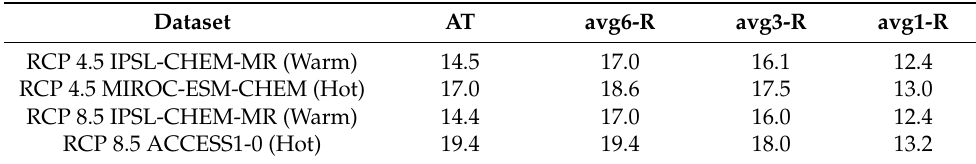
Table 13. Predicted average temperatures for 2012–2017, full dam steady state. Dataset AT avg6-R avg3-R